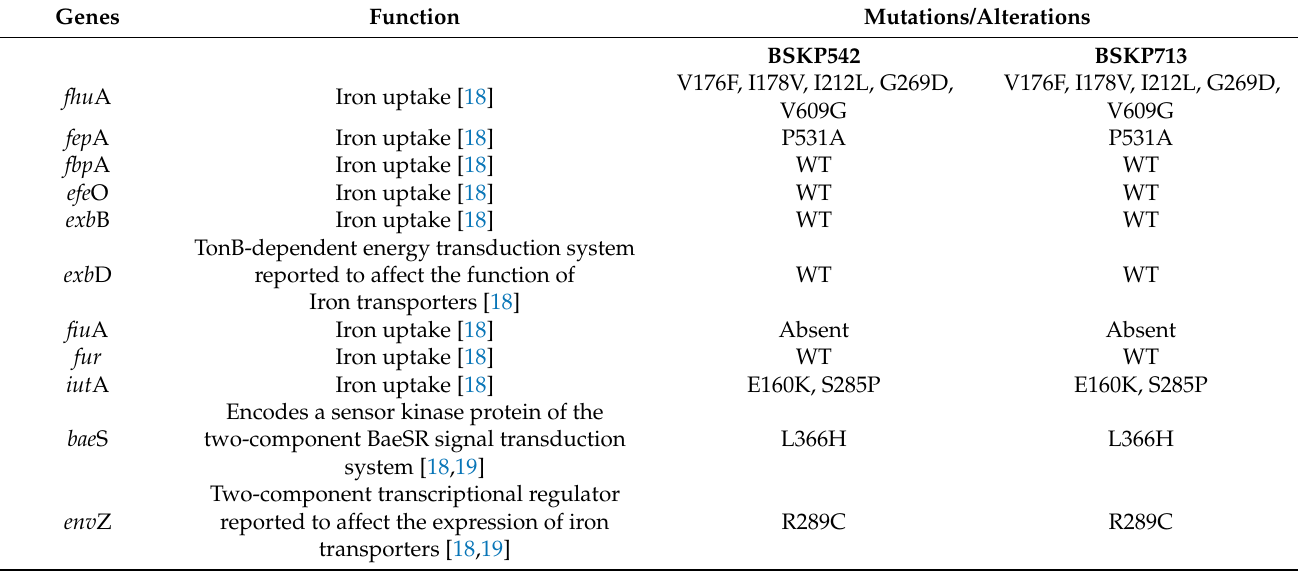
Table 3. Analysis of possible mutations in genes involved in iron uptake and transport